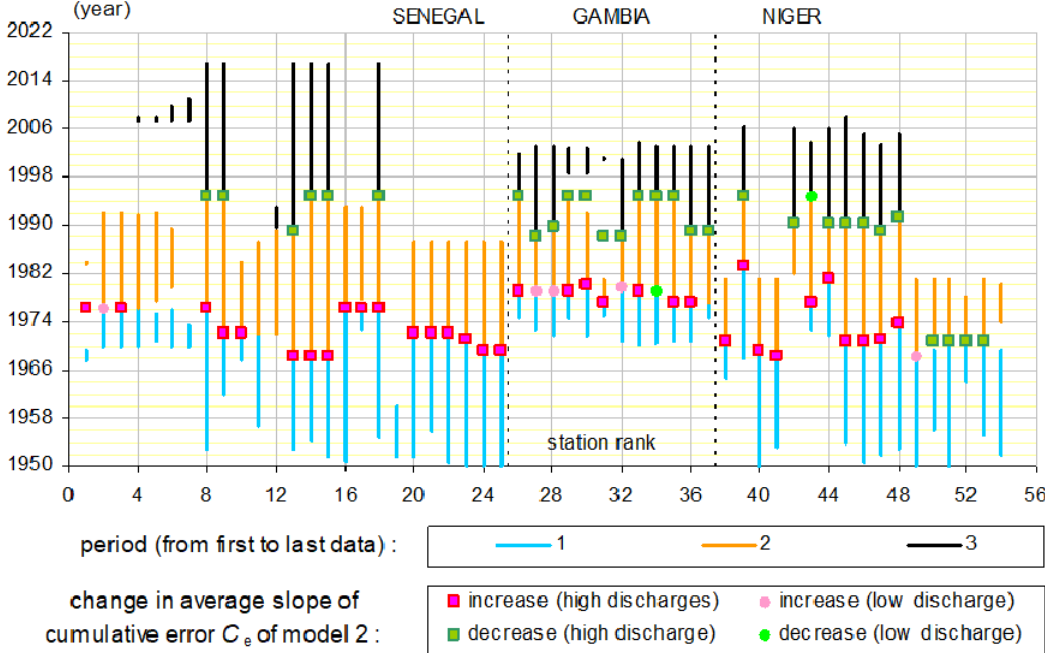
Figure 15. Division of the data series into successive periods for each station, based on the dates of change in the overall slope of the time accumulation C e of the model 2 error.